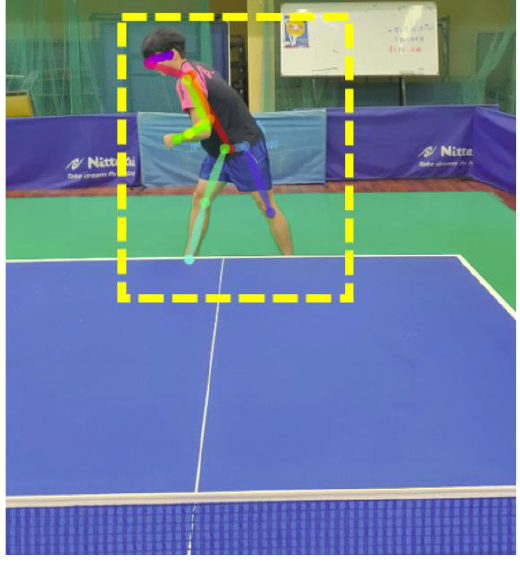
Figure 10. The pose caused by the angle of the film is not easily interpreted.